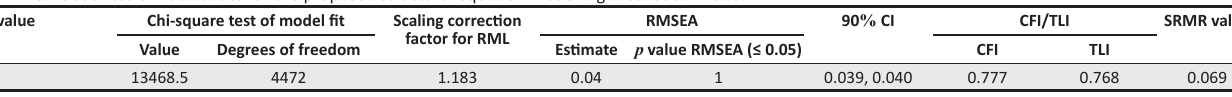
TABLE 6: Goodness of fit statistics for the proposed structural equation modelling theoretical model. p value